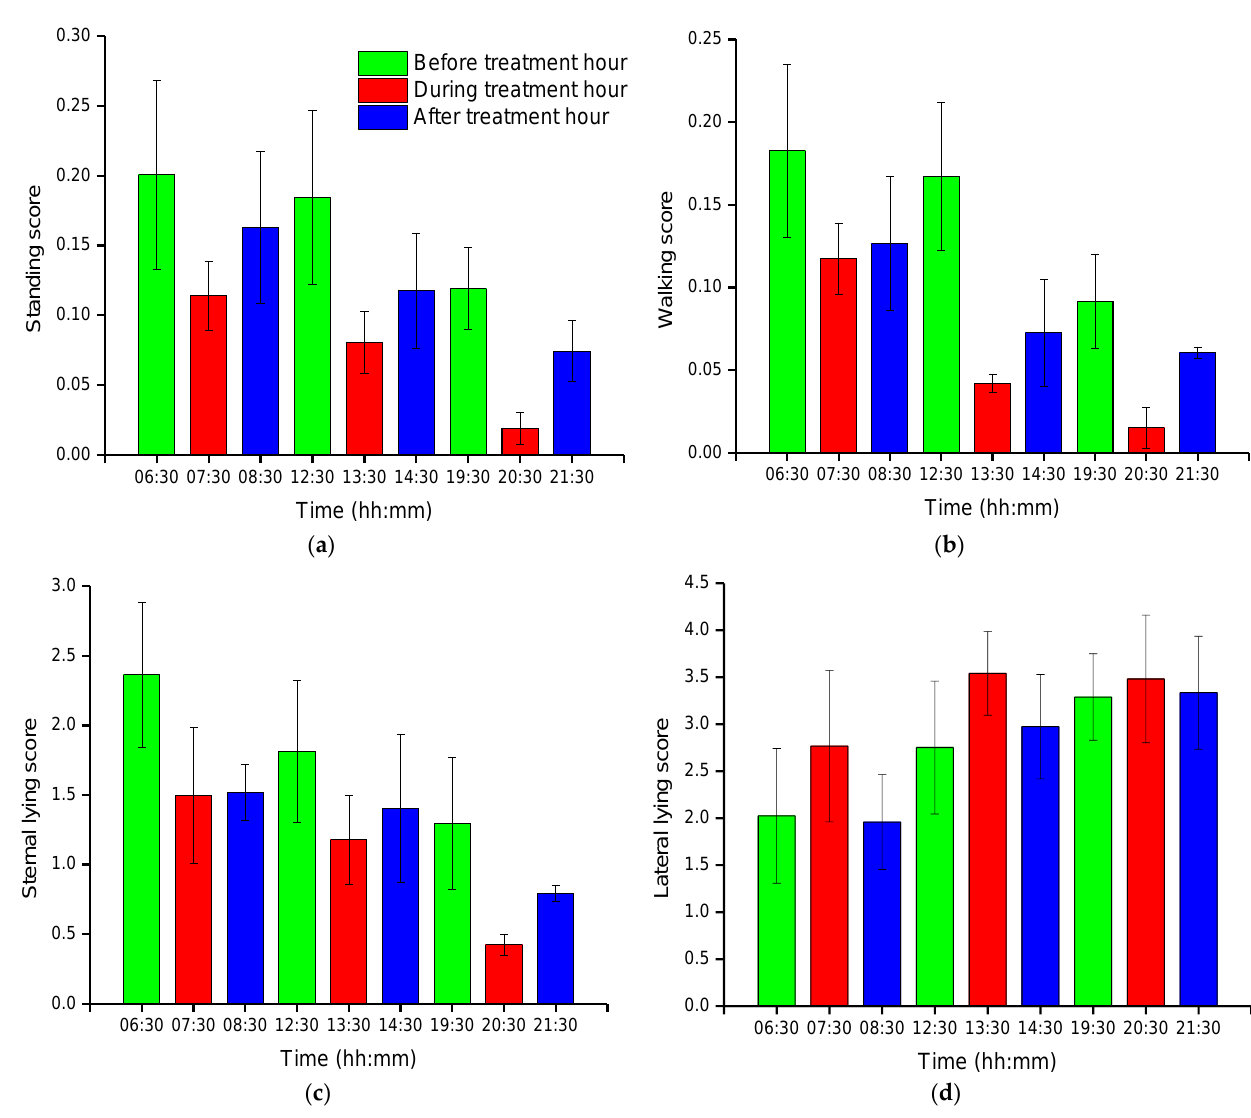
Figure 7. Group-wise average posture and walking frame scores of pigs: ( a ) standing score, ( b ) walking score, ( c ) sternal- lying score, and ( d ) lateral-lying score. The scores show the average number of pigs in a frame with a particular posture. The bars represent the average activity scores obtained in three days at an hour before, during, and after the treatment period in the morning, day, and nighttime.